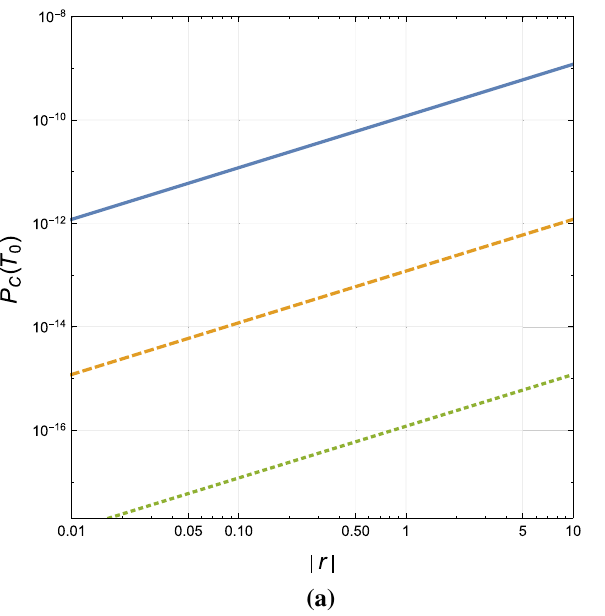
Fig. 5 In a logarithmicscaleplotsofthedegreeofcircularpolarization P C ( T 0 ) as a function of | r | for magnetic field amplitude B e 0 = 10 − 9 G and CMB frequencies ν 0 = 10 8 Hz (continuous line), ν 0 = 10 9 Hz (dashed line) and ν 0 = 10 10 Hz (dotted line) are shown. In b loga- rithmic scale plots of the degree of circular polarization P C ( T 0 ) as a